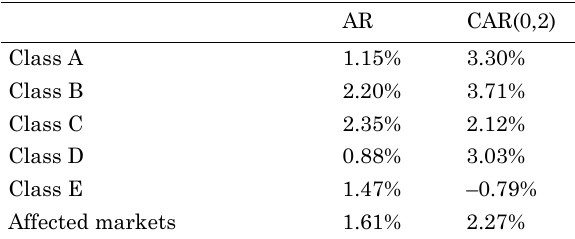
table 9. event study results for the introduction of Special Stamp Duty in nov 2010 ar car(0,2) class a